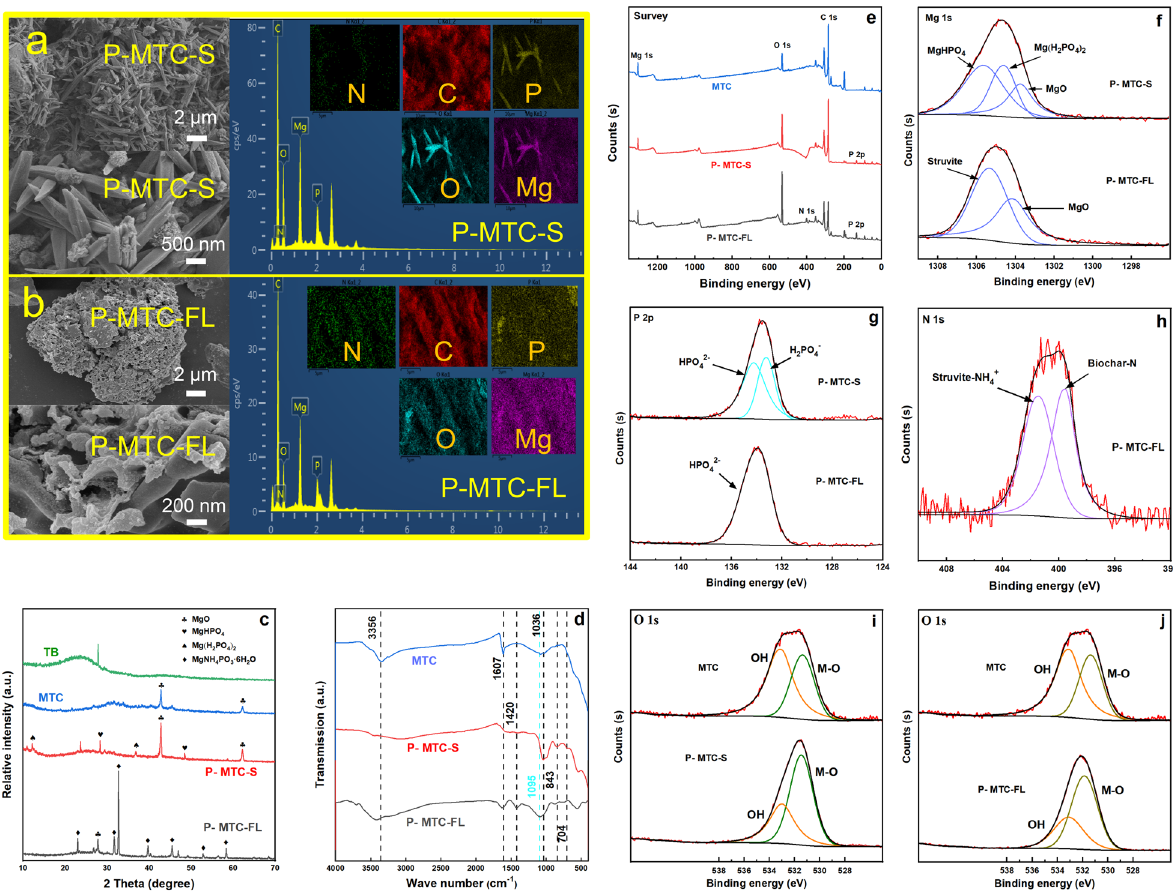
Fig. 7 SEM and EDS images of MTC after adsorption of P from the synthetic solution (P-MTC-S) and the kitchen waste fermentation liquid (P-MTC-FL) ( a , b ); XRD ( c ) and FTIR ( d ) analysis of MTC before and after adsorption of P from phosphate solution (P-MTC-S) and fermentation liquid (P-MTC-FL); XPS wide survey spectra ( e ), high resolution spectra of Mg1s ( f ), P2p ( g ), N1s ( h ) and O1s ( i , j ) after adsorption of P from P-MTC-S and